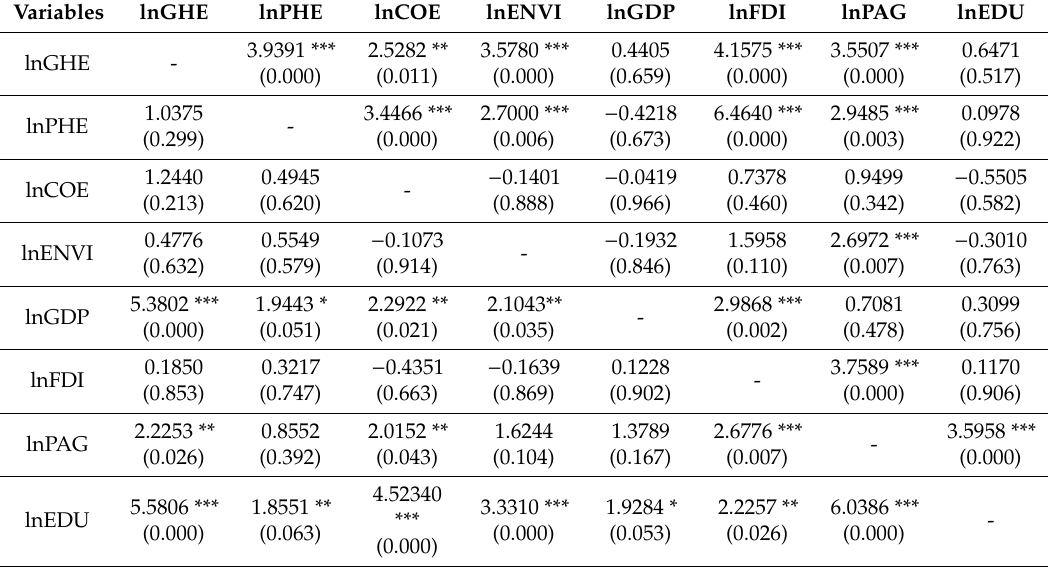
Table 7. Dumitrescu and Hurlin heterogeneous panel causality test